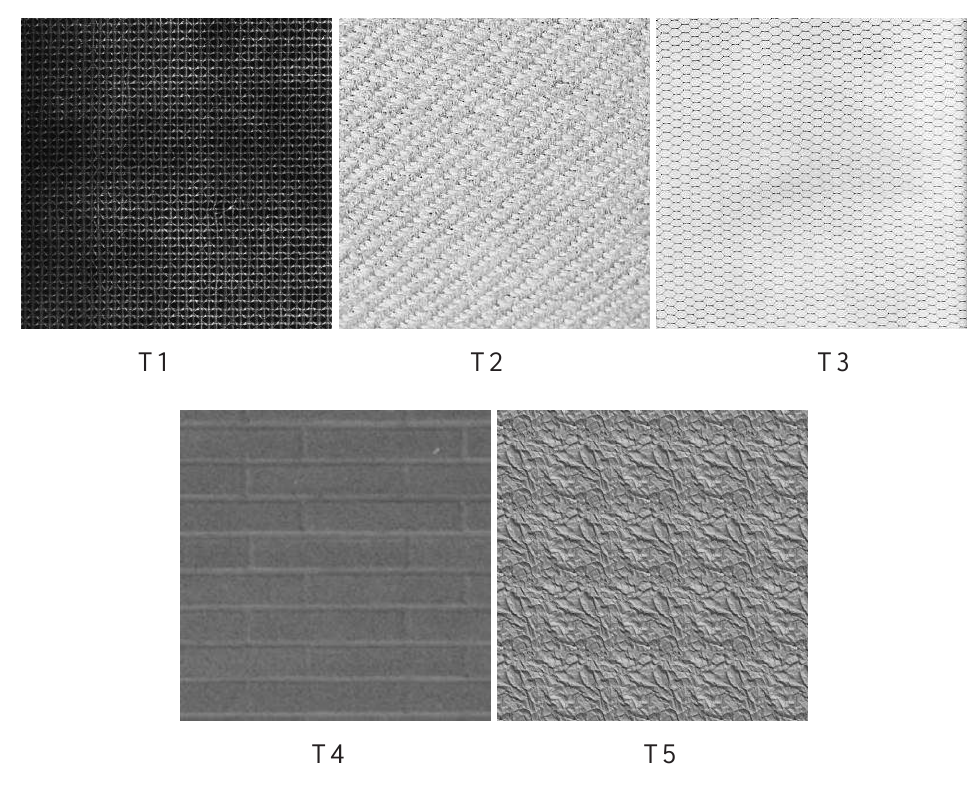
Figure 18. The textures considered in the